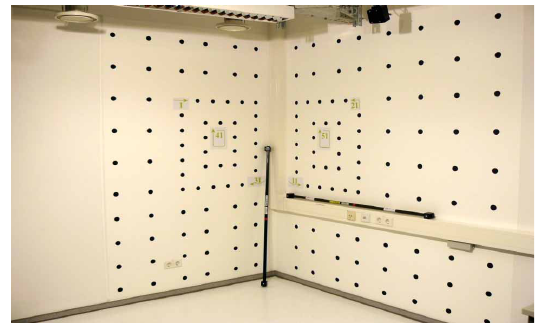
Figure 6: Calibration target with calibrated